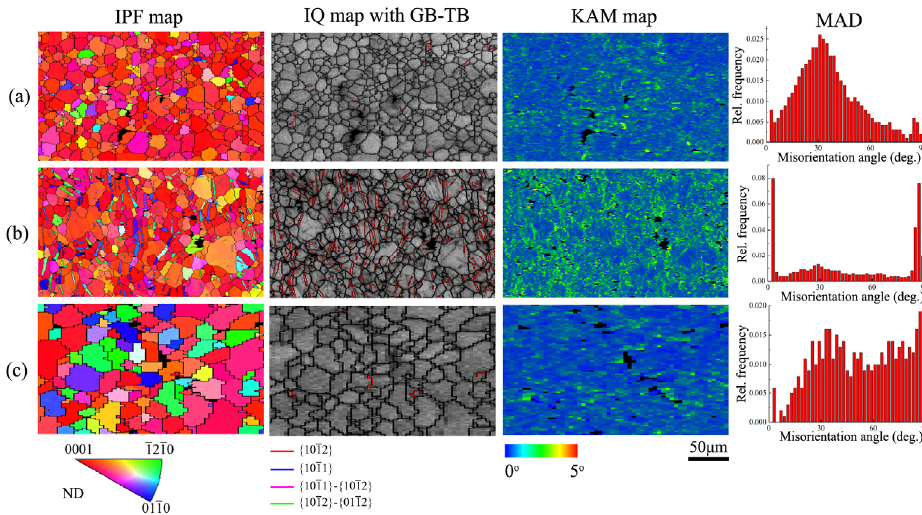
Figure 2. Electron backscatter diffraction (EBSD) inverse pole figure maps (IPF), image quality maps (IQ) with grain boundary and twin boundary (GB-TB), kernel average misorientation maps (KAM) of various samples and misorientation angle distribution (MAD): ( a ) as-rolled sample; ( b ) wavy bent (WB) sample; ( c ) wavy bent annealed (WBA) sample.